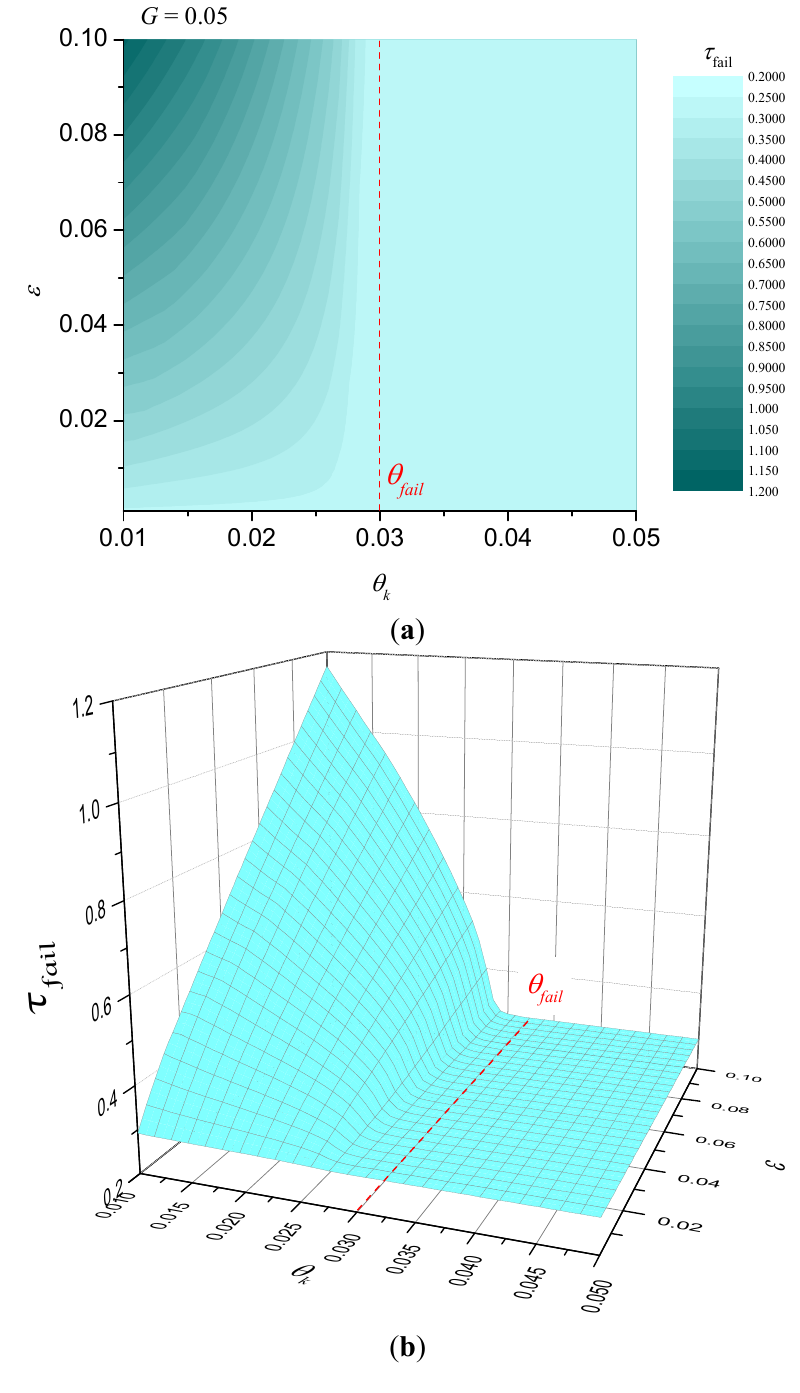
Figure 4. Illustration of dimensionless failure time for G = 0.05 (failure at exposed surface). ( a ) contour plot; ( b ) surface